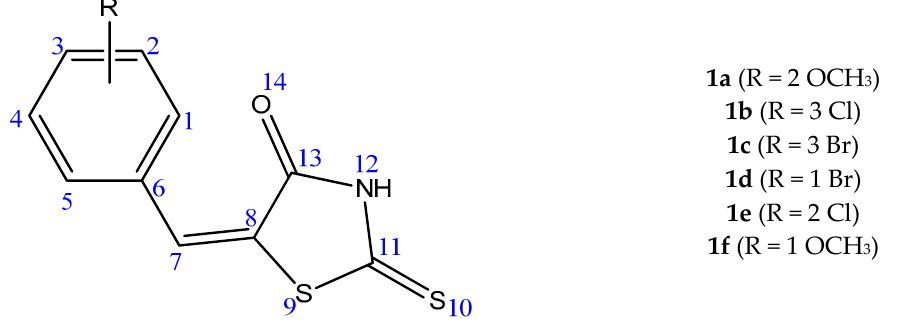
Figure 3. The structure of the 5-arylidene-2-thioxothiazolidin-4-one derivatives 1a – f , R = various substituents.